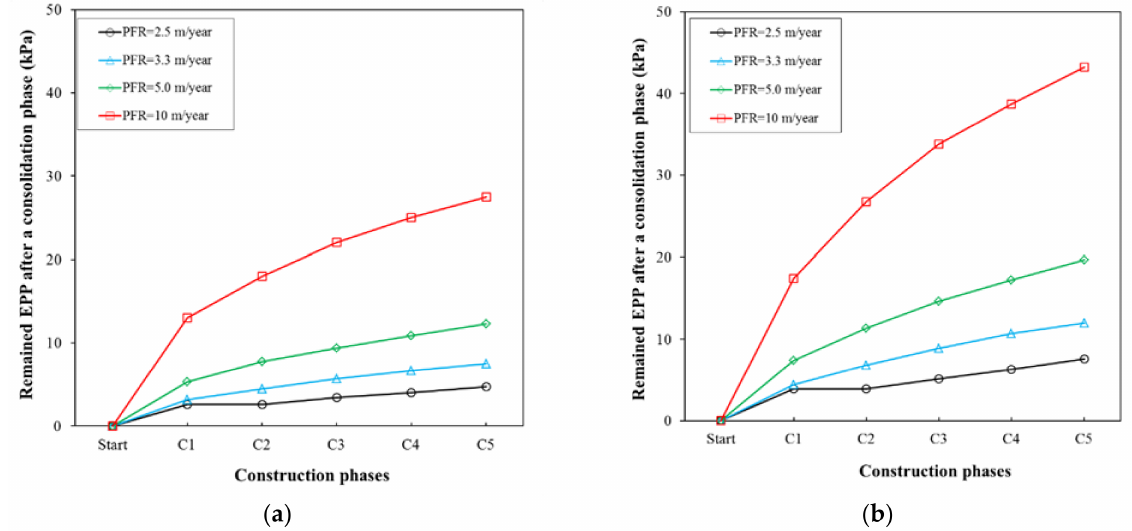
Figure 12. Effect of the pond filling rates ( PFR ) on the build-up of EPP during the stage of construction at: ( a ) point A and ( b ) point B (defined in Figure